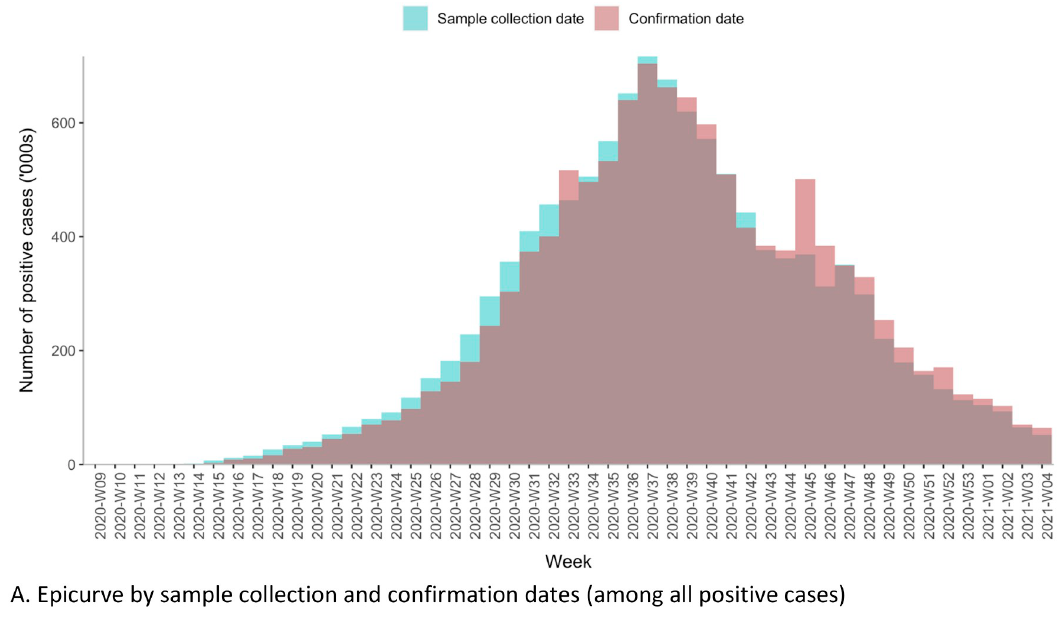
The Median (IQR) duration between symptom onset and sample collection was 2 (IQR: 0 to 3) days, and that between sample collection and testing and between testing and reporting were 0 (IQR: 0 to 1) days. There was no difference in the duration between a negative and positive